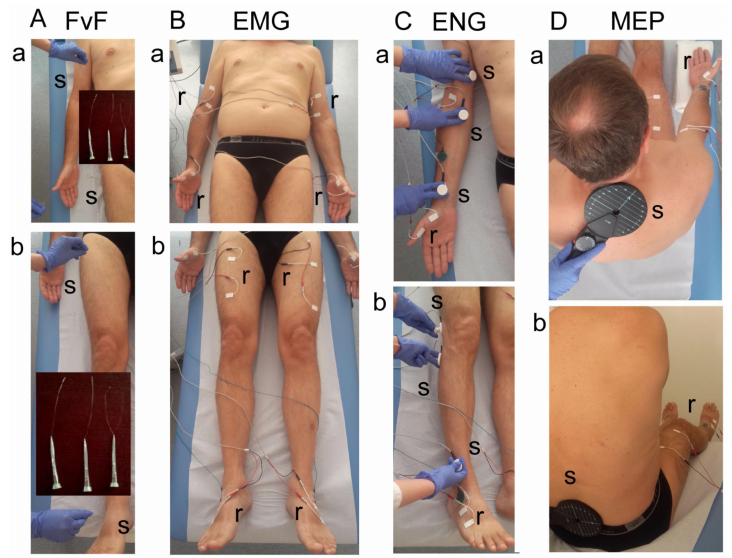
Figure 2. Photograph illustrating the methodological details of clinical neurophysiology diagnostic tests. ( A )—Method of tactile testing the sensory perception with von Frey’s filaments (FvF) within the dermatomes of ( a ) upper and ( b ) lower extremities. ( B )—Electromyographic (sEMG) testing of motor units’ activity using the surface electrodes with the locations over muscles of ( a ) upper and ( b ) lower extremities. ( C )—Electroneurographic (ENG) recordings of the evoked potential from muscles of ( a ) upper and ( b ) lower extremities with the surface electrodes following the stimulation of median and peroneal nerves along their anatomical passage, respectively. ( D )—The method of motor evoked potentials (MEP) recordings induced by the single magnetic stimuli applied oververtebrally to the spinal cord centers at the ( a ) cervical and ( b ) lumbar levels. Abbreviations: r—recording,